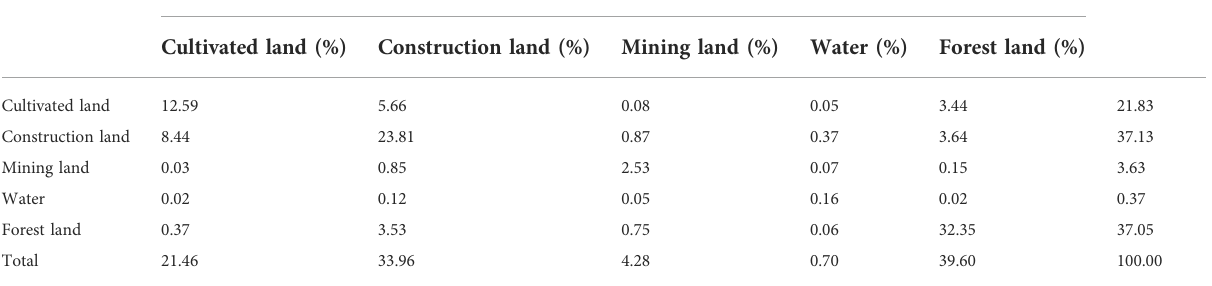
TABLE 4 Land use transfer matrix in Anshan urban area from 2008 to